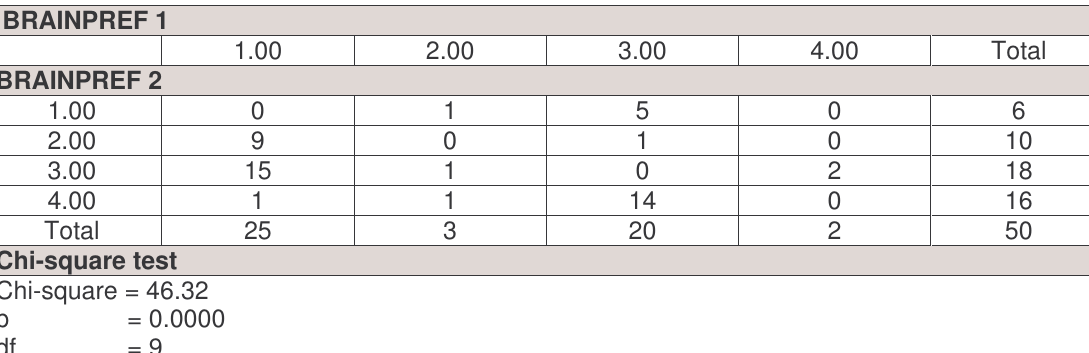
Table 5: Cross tabulation of Brain Preference 1 and Brain Preference 2 BRAINPREF 1 1.00 2.00 3.00 4.00 Total BRAINPREF 2